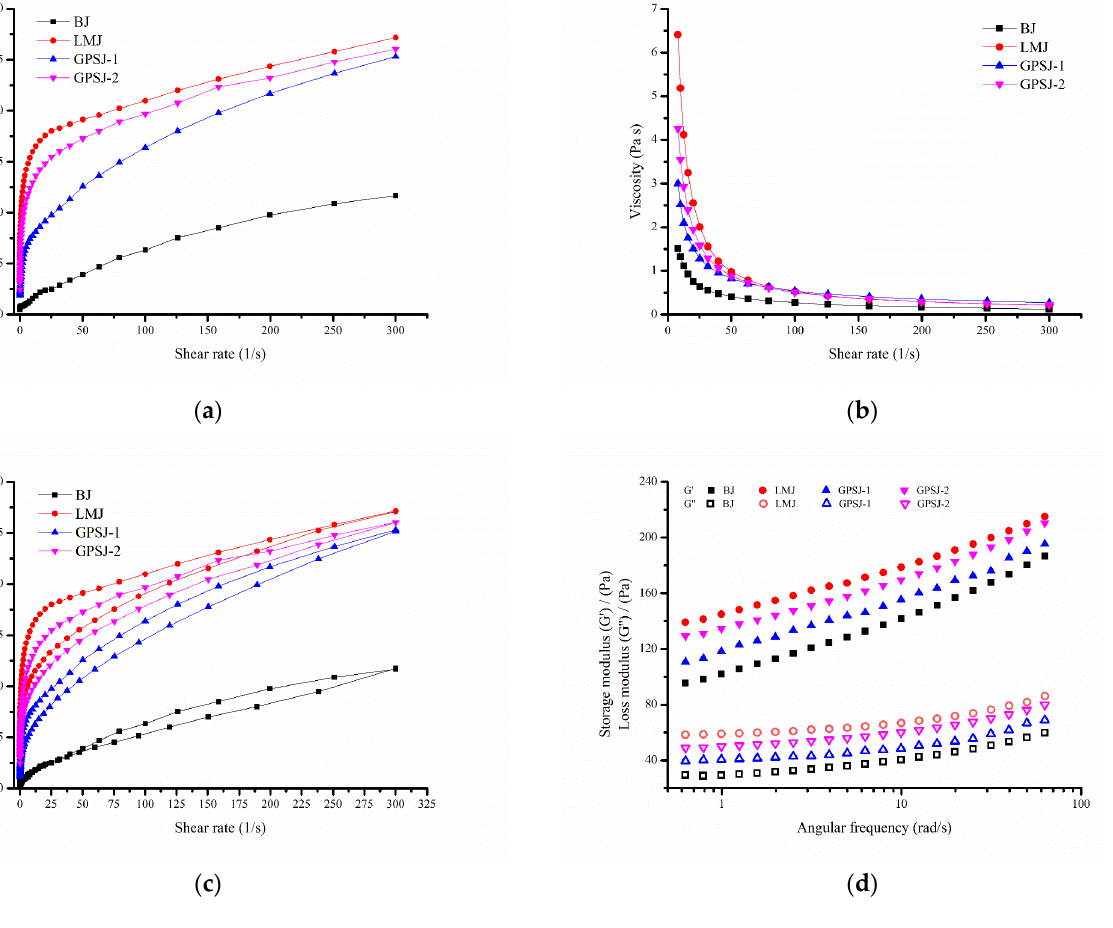
Figure 5. The rheological characteristics of blueberry jam. Variations in shear stress ( a ) and viscosity ( b ) with the shear rate. ( c ) Thixotropy. ( d ) Variations in storage modulus (G′) and loss modulus (G″) with the angular frequency. Table 2. Herschel–Bulkley and textural parameters for blueberry